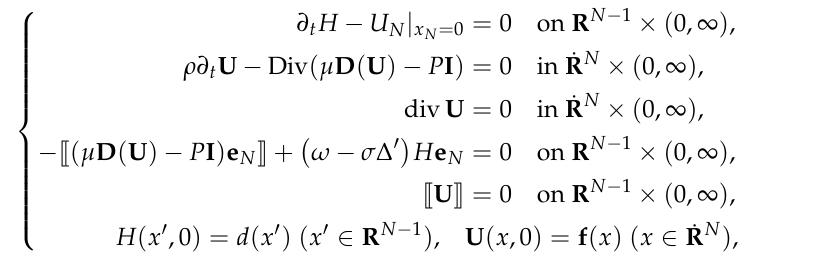
( t ) and the interface Γ ( t ) ±